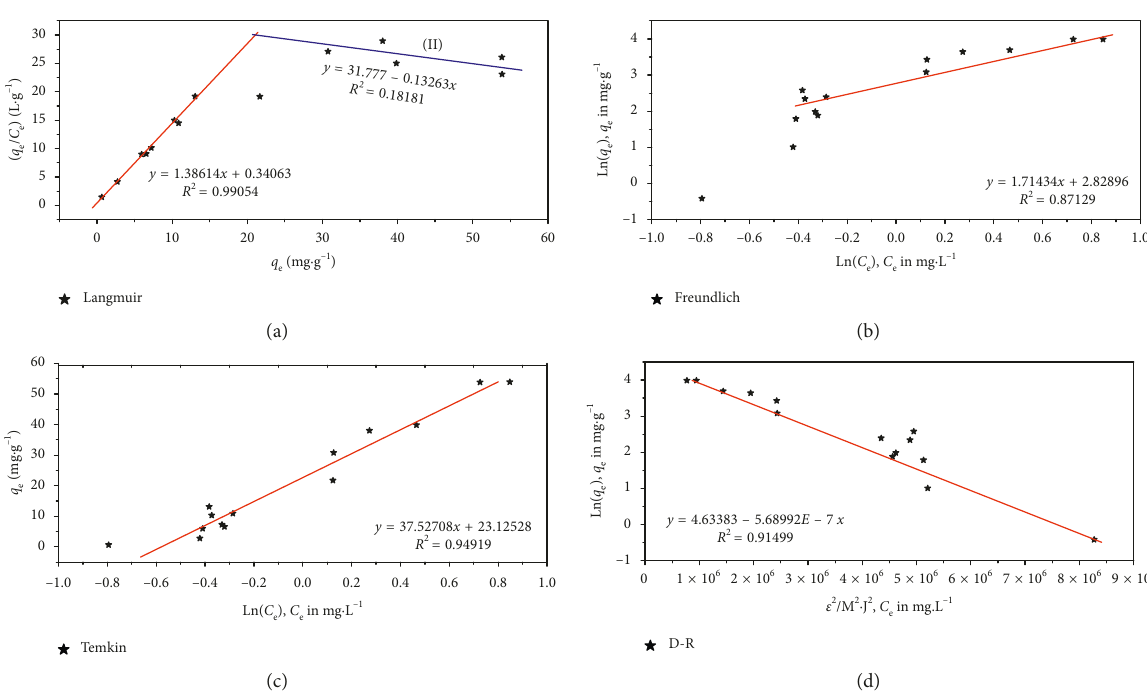
Figure 12: Adsorption isotherms of Cd(II) on BPP: (a) Langmuir, (b) Freundlich, (c) Temkin, and (d) D-R